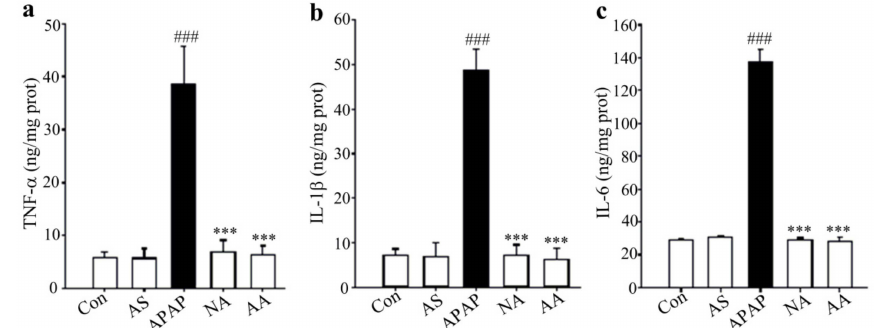
Figure 4. E ff ects of AS on proinflammatory cytokines. ( a ) Hepatic TNF- α levels. ( b ) Hepatic IL-1 β levels. ( c ) Hepatic IL-6 levels. Data are expressed as means ± SD ( n = 10). ### p < 0.001 compared to the Con group; *** p < 0.001 compared to the APAP